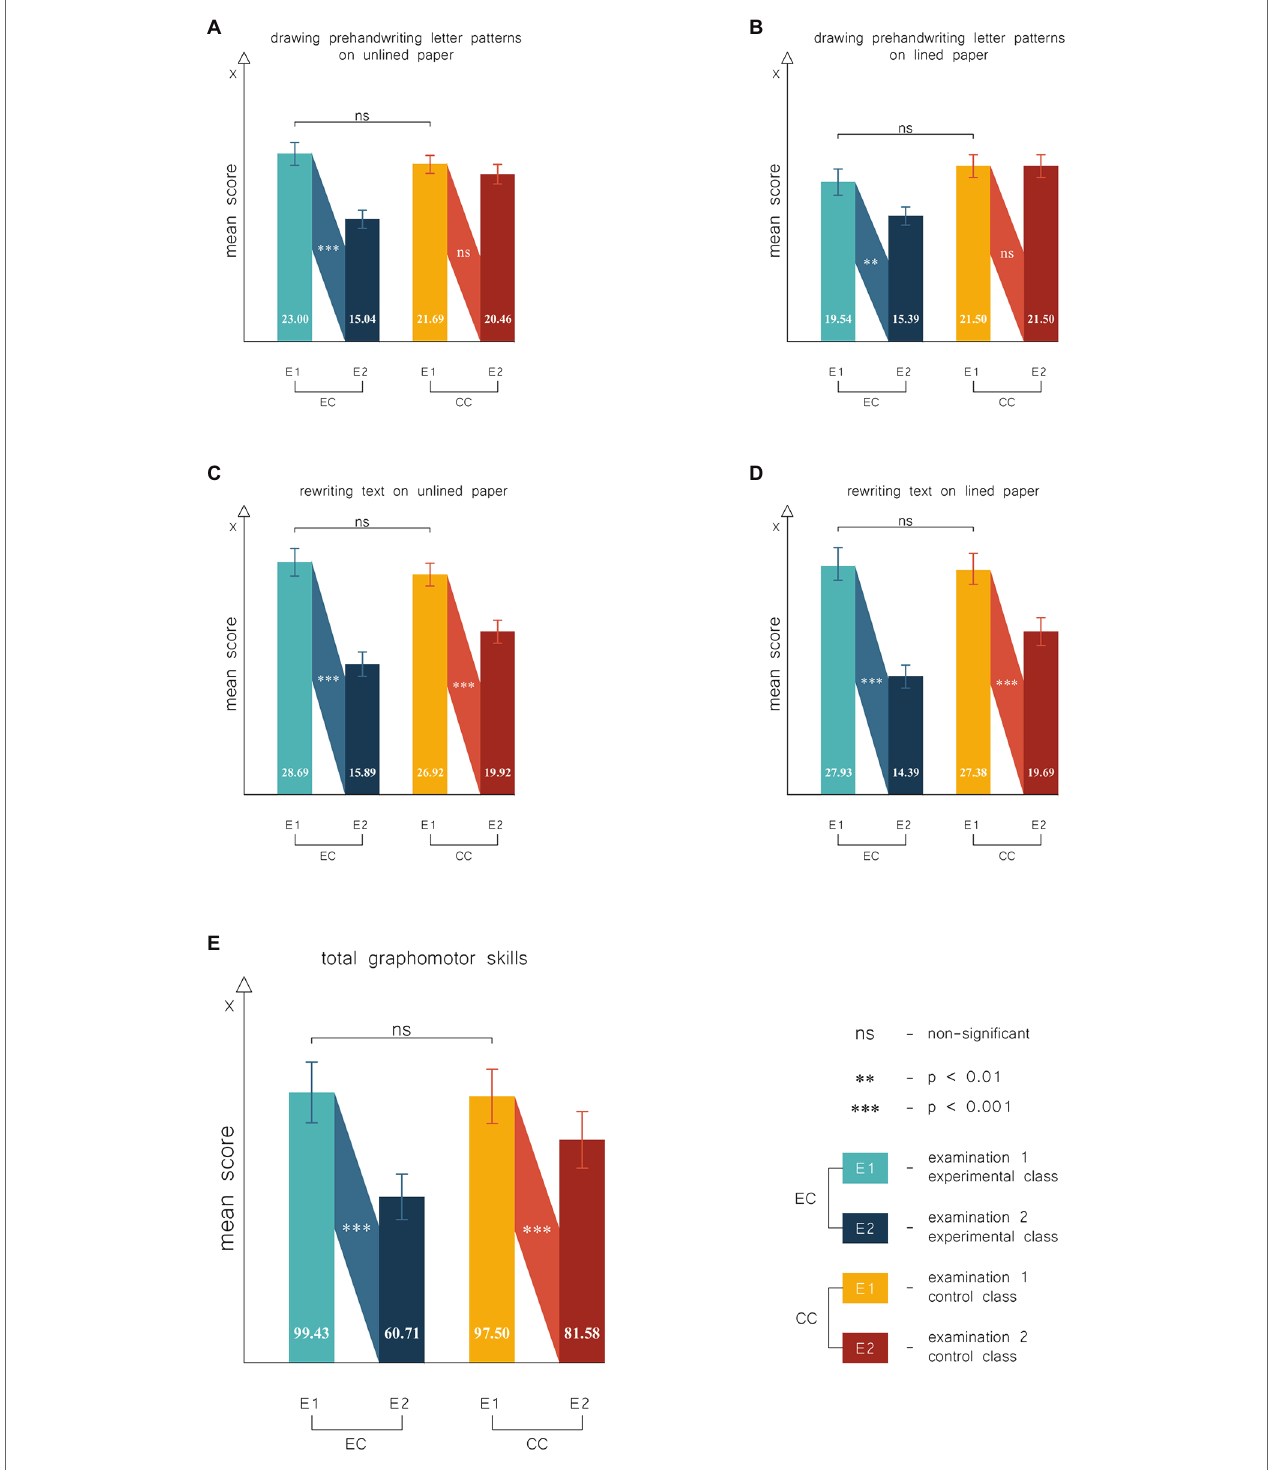
FIGURE 2 | Results of the experiment in terms of graphomotor skills. (A) Results of trial: drawing prehandwriting letter patterns on unlined paper. (B) Results of trial: drawing prehandwriting letter patterns on lined paper. (C) Results of trial: rewriting text on unlined paper. (D) Results of trial: rewriting text on lined paper. (E) Results of the experiment in terms of the total graphomotor skills (the sum of four trials). Higher points indicated poorer handwriting performance. Error bars depict SEs of the means. EC, experimental class; CC, control class; Examination 1, pretest carried out at the beginning of the spring semester (in January); and Examination 2, posttest carried out at the end of the school year (in